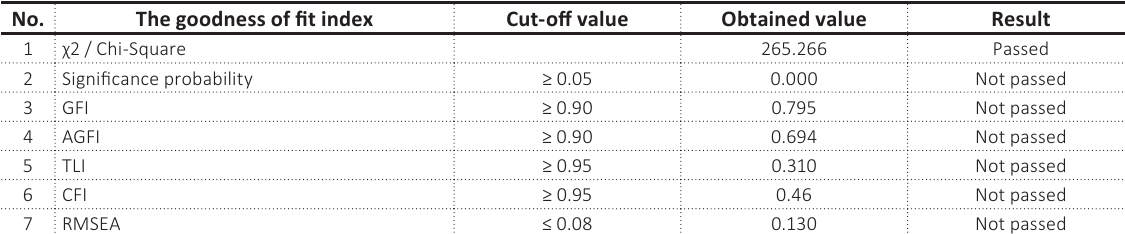
Figure 5. Moderating SEM analysis with a mixed-method approach Table 6. The goodness of fit